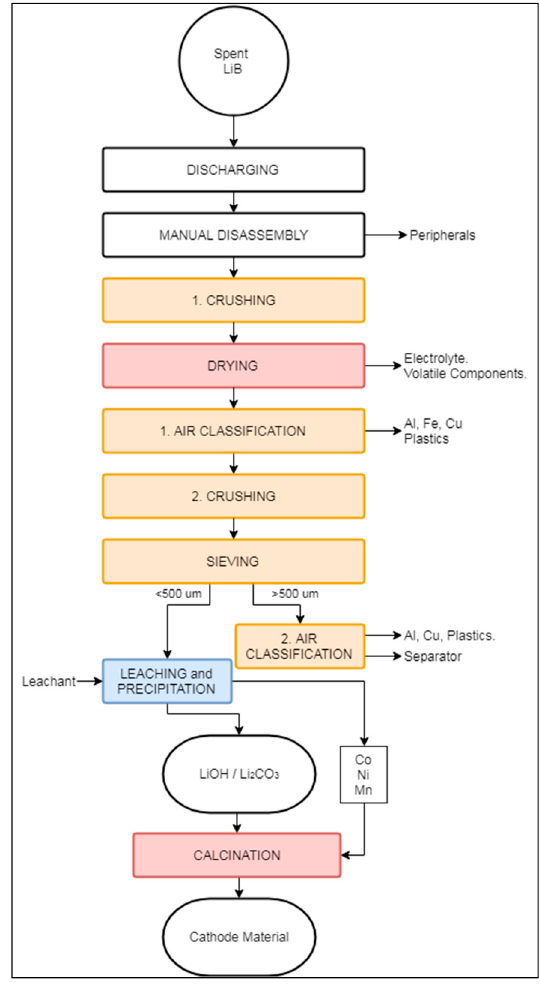
Figure 9. Schematic representation of the LithoRec recycling process.